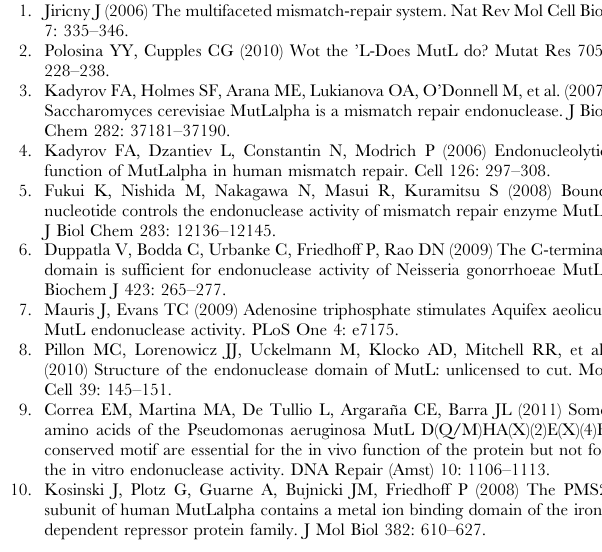
Figure S1 PaNTD and EcNTD all atom MD evaluation. Figure S2 Time evolution of dimerization interface secondary structure. Dimerization interface secondary struc- ture along the 200 ns of the MD simulation was determined for PaNTD and EcNTD, with or without ATP, using DSSP. A) ATP lid (PaNTD r. 78–101, EcNTD 74–97); B) L1 (PaNTD r. 6–24, Figure S3 Percentage of predicted helical content of EcNTD, PaNTD and TmNTD ATP lid using AGADIR. The sequence of the helical region of EcNTD (r. 79–90), PaNTD (r. 83–94) and Termotoga maritima NTD (TmNTD, 85–96) ATP lid were used to calculate the tendency of these peptides to form alpha helix. Figure S4 PaNTD oligomeric state after ON incubation in EDTA. PaNTD (10 m M) in 20 mM HEPES (pH: 7.4), 150 mM KCl, 10% glycerol, 5 mM MgCl 2 and 1 mM DTT